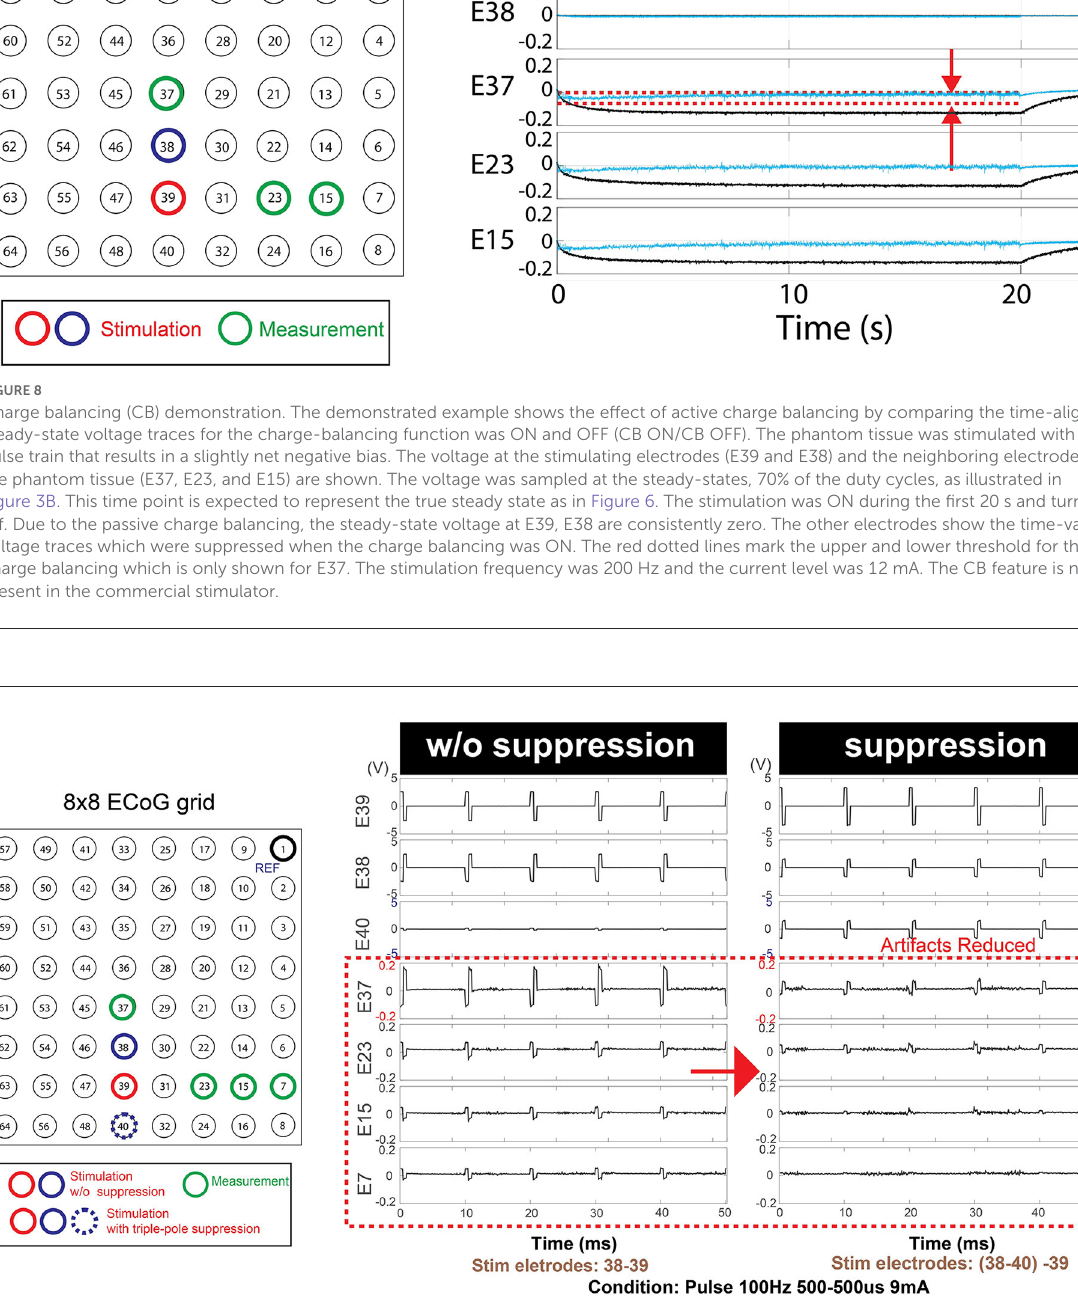
FIGURE9 Additional optional safety feature: Artifact mitigation by triple-pole technique. An extra stimulation pole (E40) in addition to the existing stimulation dipole (E38-E39) contributed to the overall mitigation of the artifacts over the entire grid space. This feature is not present in the commercial